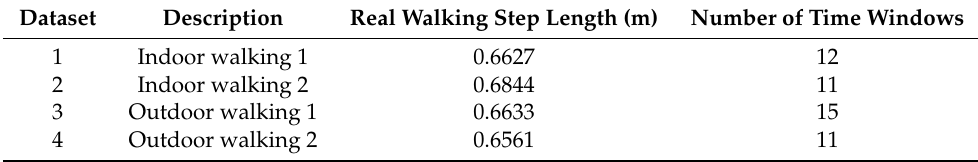
Table 1. Real walking step length and the number of time windows in the